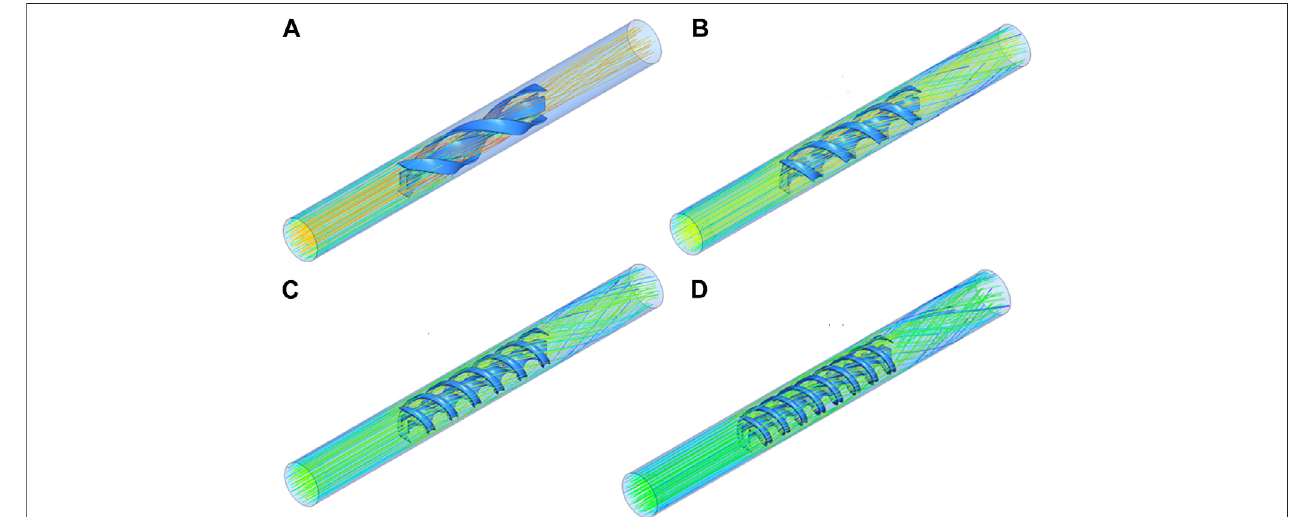
FIGURE 6 | The streamlines at torsion ratios of (A) n (cid:1) 1, (B) n (cid:1) 2, (C) n (cid:1) 3, and (D) n (cid:1) 4.